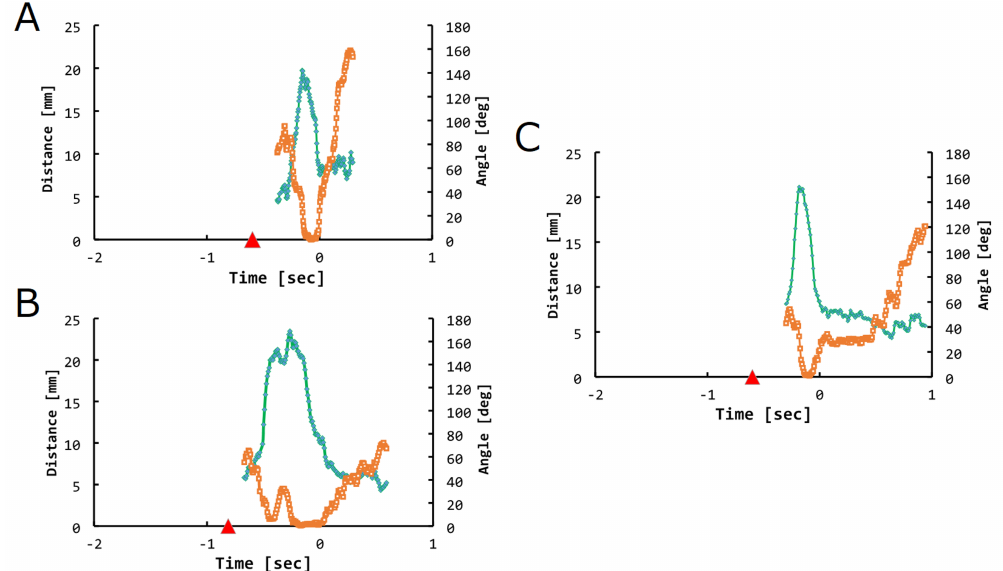
Fig. 6. Changes in the two-fingertip distance and pronation angle from a representative subject. The distance between the first and fifth fingertips (green) and the angles between the two-fingertip line and the horizontal line in pronation and supination are plotted before (A), 6th days after (B), and 15th days after (C) the cortical lesion. Representative pictures for pronation and supination are shown in Fig. 2A,B, respectively. Representative data are shown in this graph. The time zero on the x-axis indicates the instant when the rat grabbed the pellet. The left and right halves of the orange curves indicate pronation and supination, respectively. The green triangles on the x-axis indicate the instants when the dominant hand left the floor.